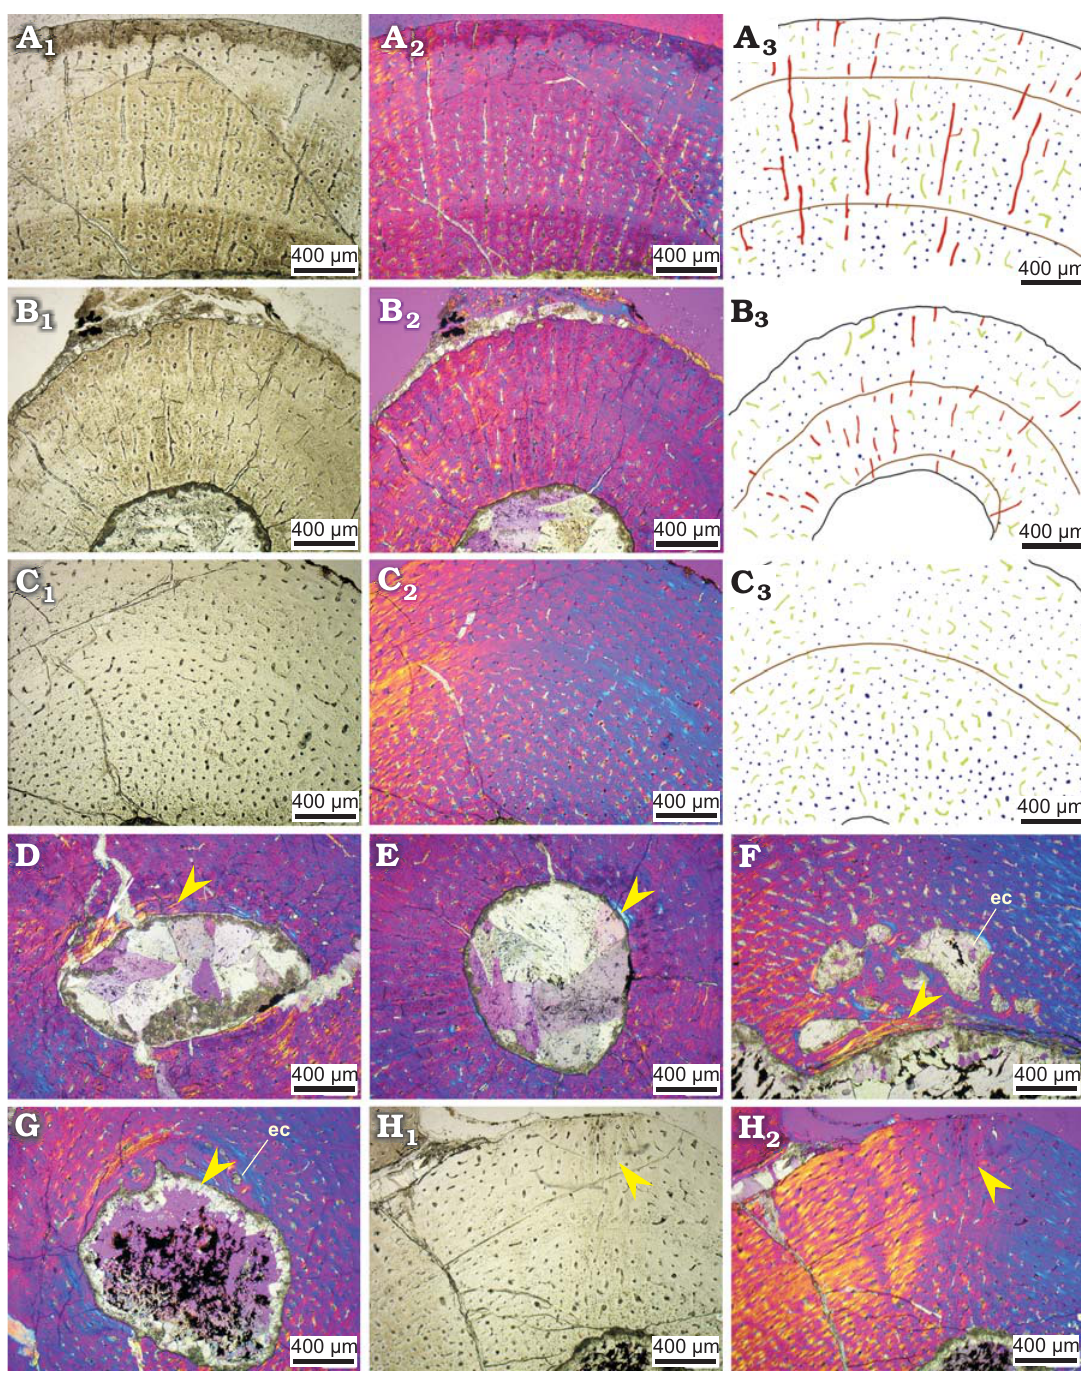
Fig. 4. Bone microstructure in juvenile ceratopsian dinosaur Psittacosaurus lujiatunensis Zhou, Gao, Fox, and Chen, 2006 from western Liaoning, China, Early Cretaceous. Mid-diaphyseal transverse section of right humerus (IVPP V14341.1, A ), right radius (IVPP V14341.6, B ), left tibia (IVPP V14341.5, C ). Endosteal bone (arrow) showing in the inner most cortex and medullary cavity of right ulna (IVPP V14341.6, D ), right radius (IVPP V14341.6, E ), right femur (IVPP V14341.1, F ), right fibula (IVPP V14341.1, G ). Sharpey’s fibres (arrows) in left tibia (IVPP V14341.5, H ). Photographs in regular transmitted light (A 1 –C 1 , H 1 ), elliptically polarized light (A 2 –C 2 , D, E, F, G, H 2 ), line drawings (A 3 –C 3 ) showing longitudinal vascular canals (navy), reticular vascular canals (green), radial vascular canals (red), and LAGs (brown lines). Abbreviation: ec, erosion